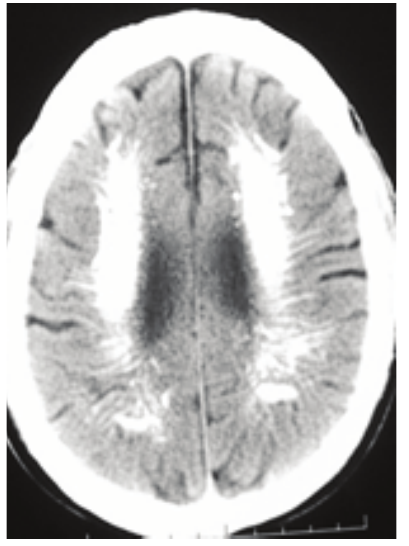
Figure 2: CT scan axial view demonstrating extensive bilateral calcifications in the periventricular white matter, semiovale center, and corona radiate.